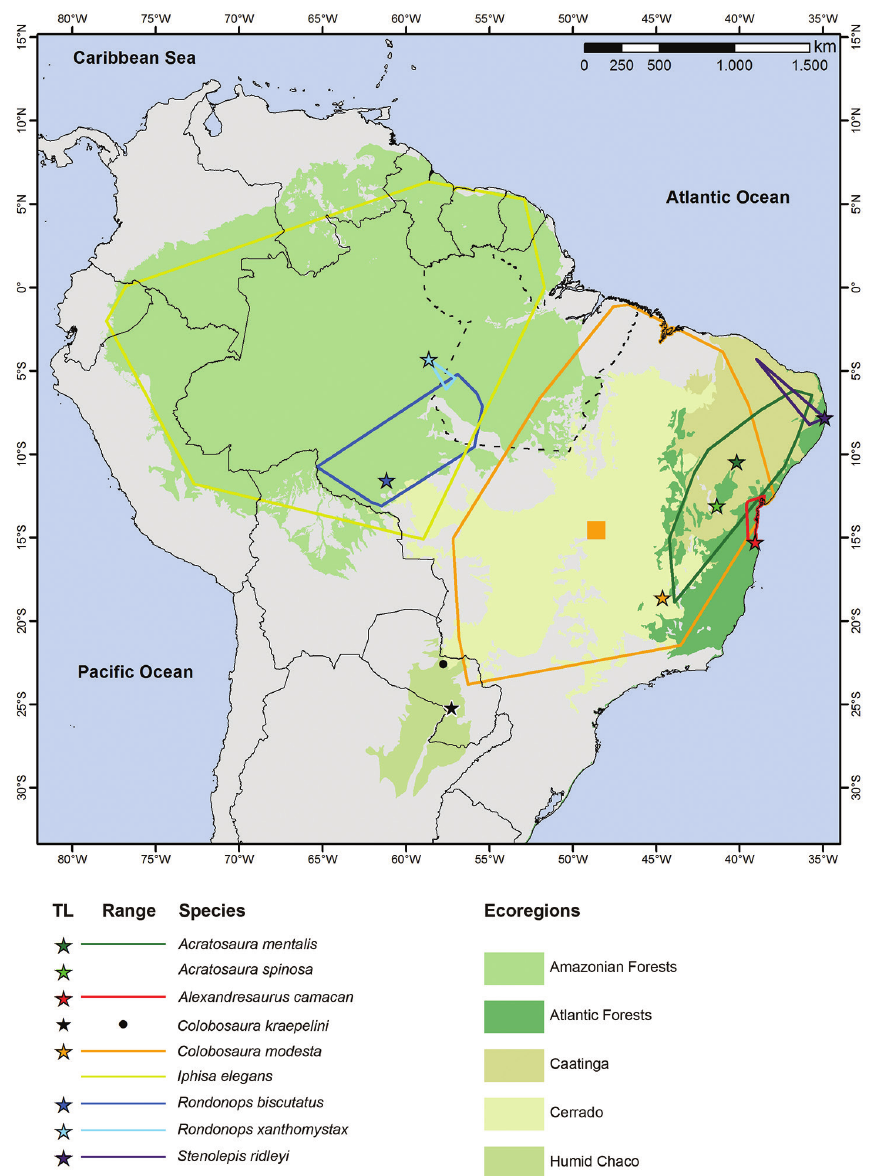
Figure 2. Central and northern region of South America showing the distribution (ranges in color) of the members of the tribe Iphisini. LT indicate type localities. Note that type locality for I. elegans is not shown since is referred as the whole Brazilian State of Pará. Range for A. spinosa is not shown because records come from vicinities of type locality. Colobosaura kraepelini is known only from two areas: the locality mentioned in the original description (black dot) and the neotype locality (black star); the second specimen of C. kraepelini reported here is from near the neotype locality. Orange square represents locality of the ge- netic sample of C. modesta (Niquelândia, GO, Brazil). Data for ecoregions according to Olson et al.